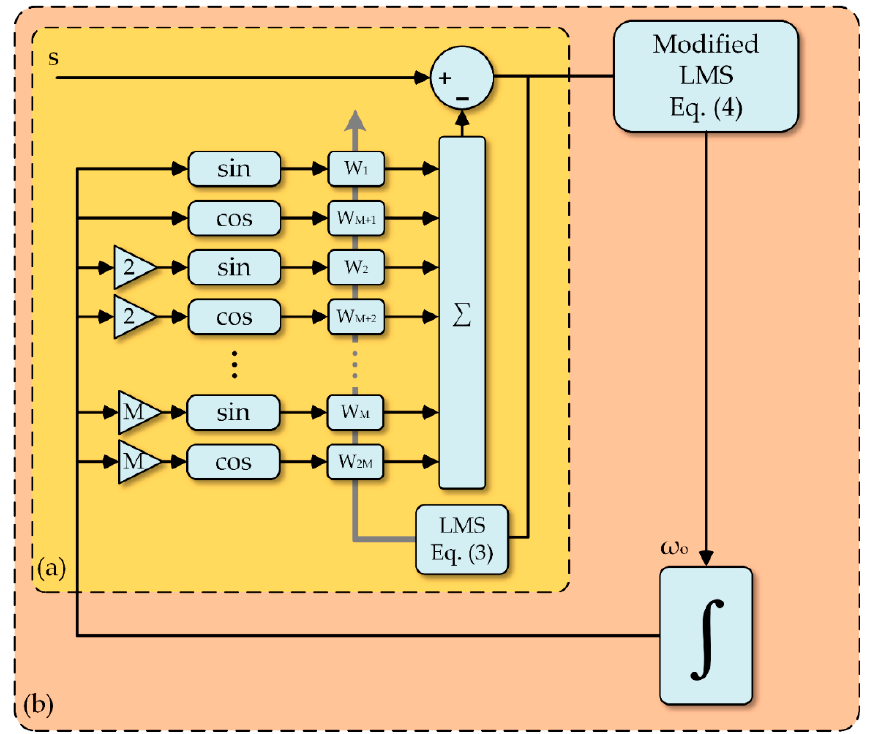
Figure 1. Standard Fourier Liner Combiner (FLC) algorithms in literature: ( a ) original FLC algorithm; ( b ) Weighted-Frequency Fourier Linear Combiner (WFLC) algorithm for fundamental frequency tracking.